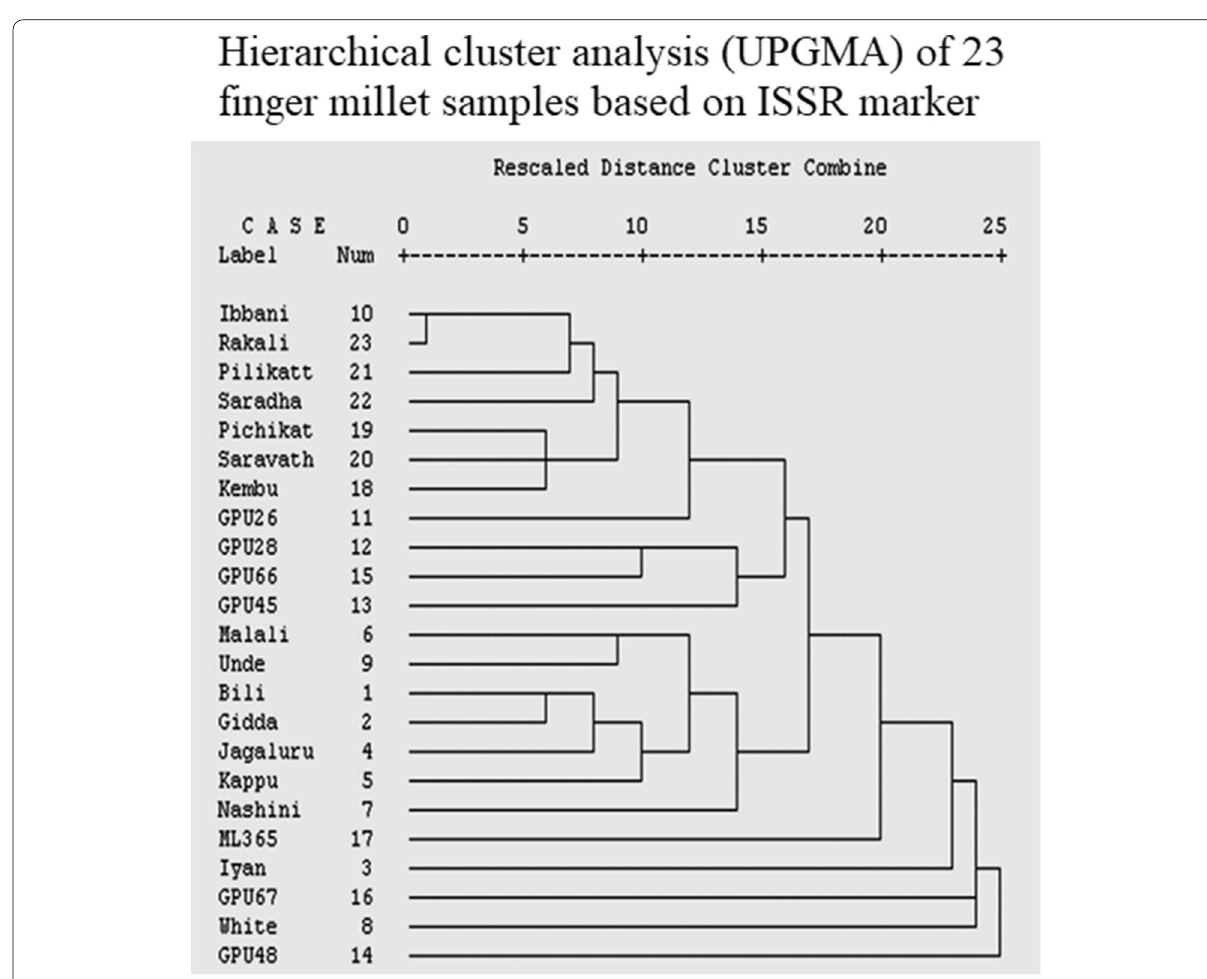
Fig. 3 Hierarchical cluster analysis (UPGMA) of 23 finger millet samples based on ISSR